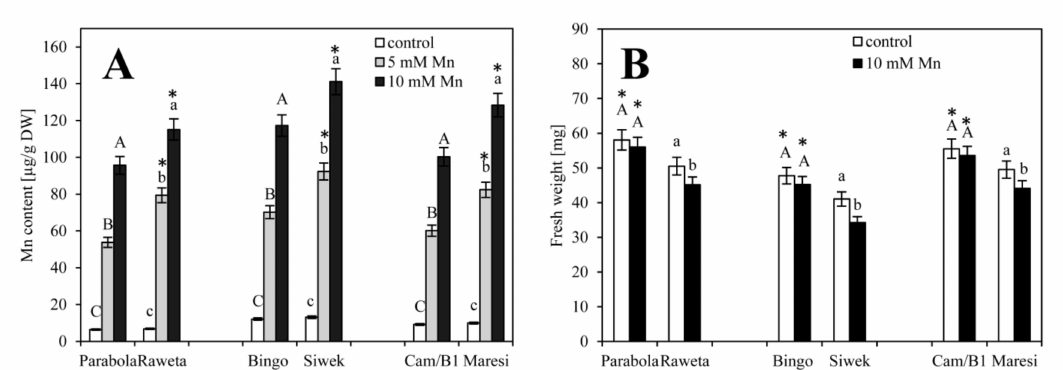
Figure 1. ( A )—Manganese content ( µ g · g − 1 DW) in grains; ( B )—fresh weight [mg] of the first leaves of wheat (Parabola-tolerant and Raweta-sensitive), oats (Bingo-tolerant and Siwek-sensitive) and barley (CAM / B1-tolerant and Maresi-sensitive) cultivars grown in water (control) and at 5 and 10 mM MnCl 2 . Values are mean of five replications ( ± SE). Di ff erent letters indicate significant ( p < 0.05) di ff erences between treatments. Di ff erences between cultivars are marked as